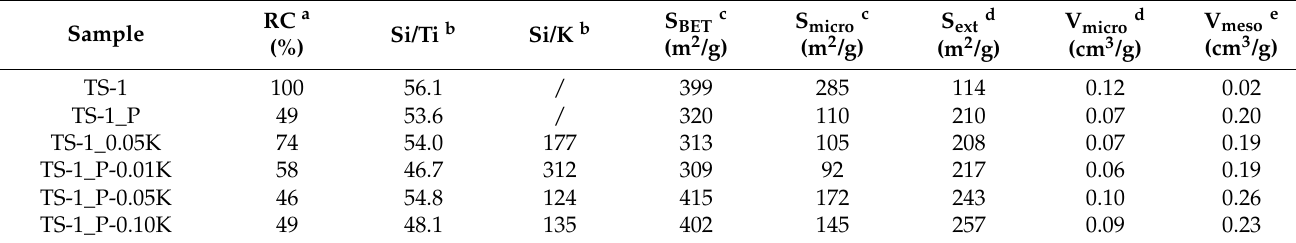
Table 1. Compositions and textural parameters of various TS-1 zeolites.